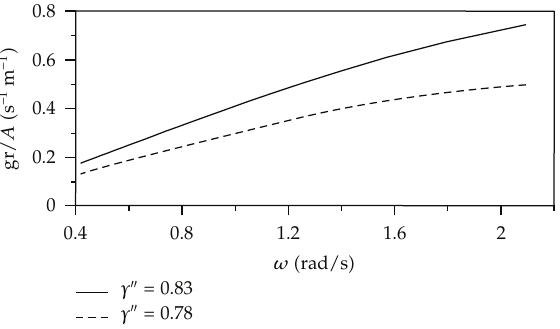
Figure 7: Growth rate of internal short waves for di ff erent density ratios of the right muddy section (cid:4) γ (cid:4)(cid:4) (cid:8) 0 . 83, 0.78 (cid:5) , water depth H (cid:8) 4m, mud layer depth h (cid:8) 0 . 1m, and density ratio of the left muddy section γ (cid:4) (cid:8) 0 .